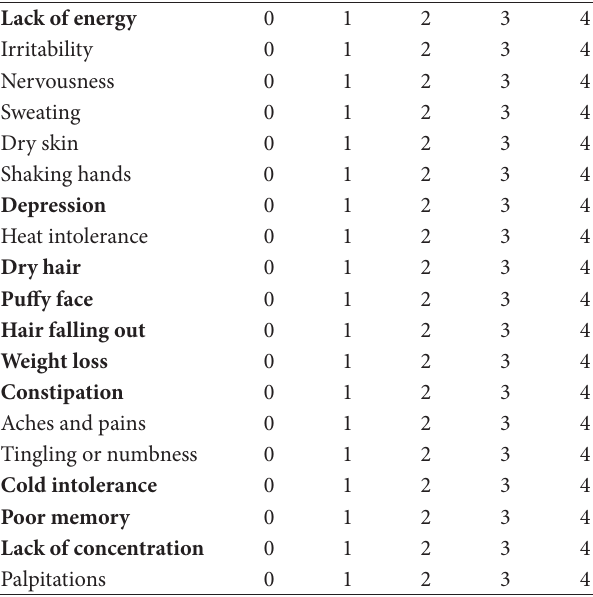
Figure 1: TSH levels in plasma at the time at which TPO positive women were first identified as PPT positive. Home visit 1 was at 1- week postpartum and the following time intervals were from month 1 through 6. Table 2: Thyroid symptom